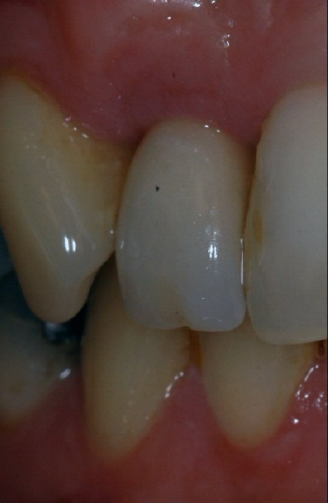
Figure 6. Final single crown restoration (cemented) three months after functional